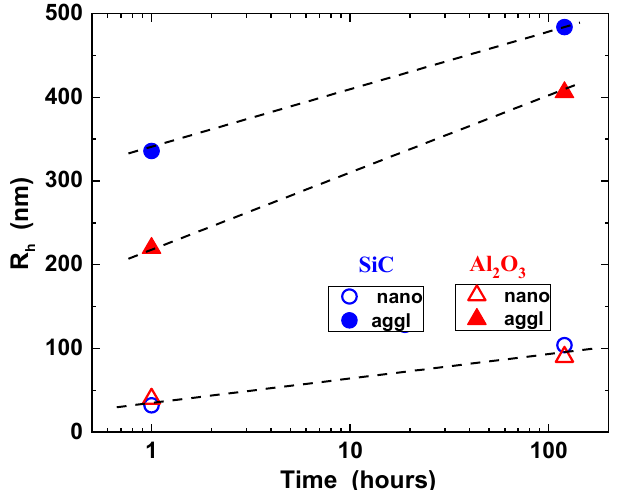
Figure 4. Hydrodynamic radii estimated by DLS data in dispersion, measured at short and long times after the dispersion preparation.